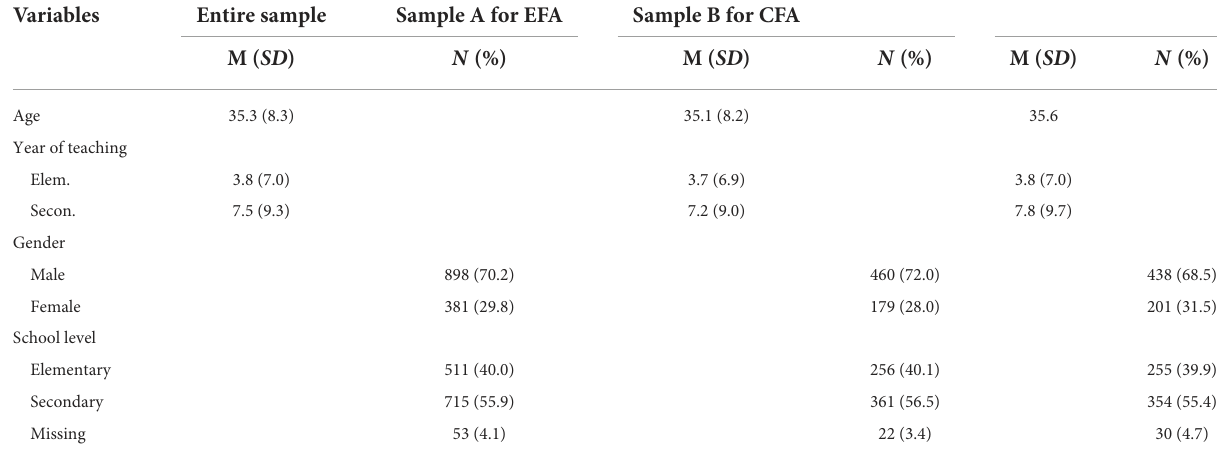
TABLE 1 Demographic information of the